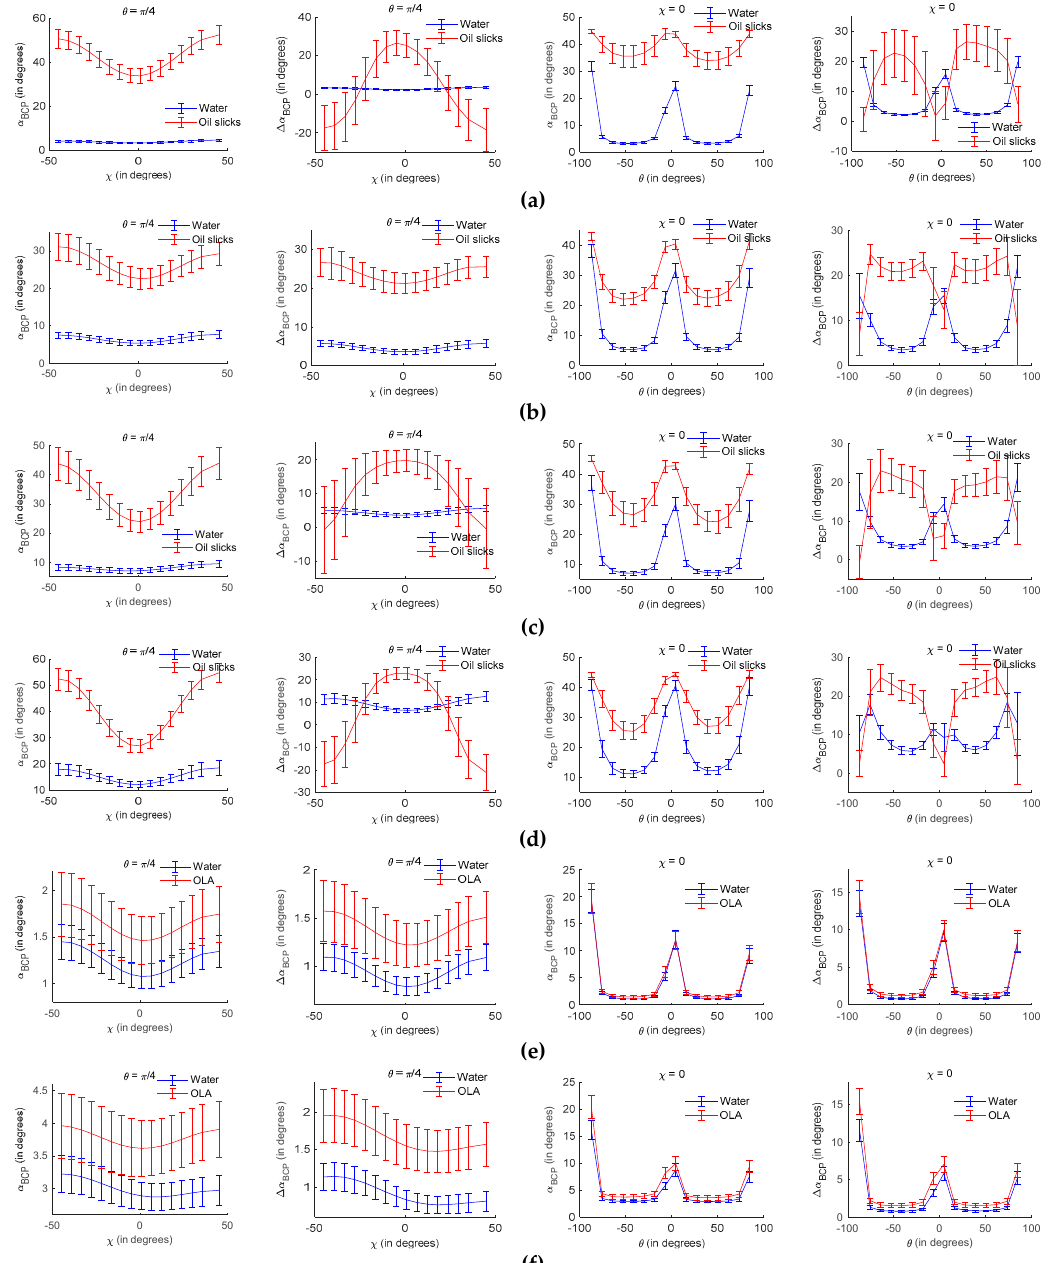
Figure 8. Variation of α BCP and ∆ α BCP values with transmitting polarizations for the water surface, oil slick, and OLA areas outlined in Figure 6. (a) ALOS/PALSAR-1 data (ALPSRP031440190); (b) RADARSAT-2 data (Penglai 19-3 oilfield); (c) SIR-C data with p.n. 17041; (d) SIR-C data with p.n. 44327; (e) SIR-C data with p.n. 41467; (f) SIR-C data with p.n. 11588.